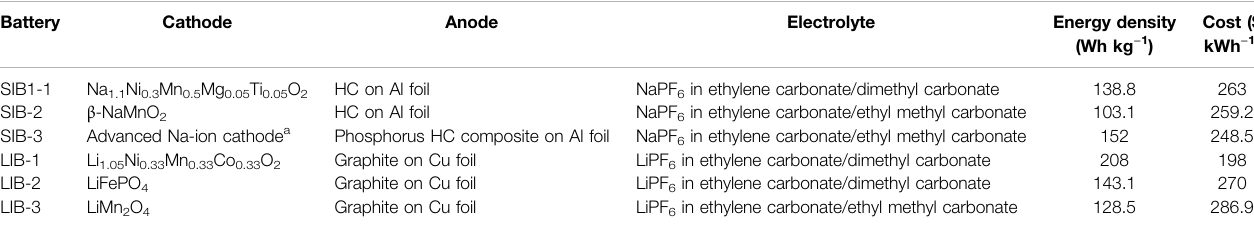
TABLE 3 | Comparison of different type of SIBs and LIBs in terms of their energy densities and costs (Peters et al., 2017; Vaalma et al., 2018). Battery Cathode Anode